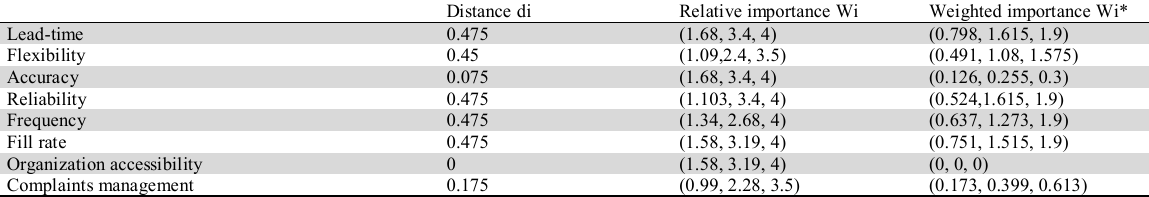
Distance di Relative importance Wi